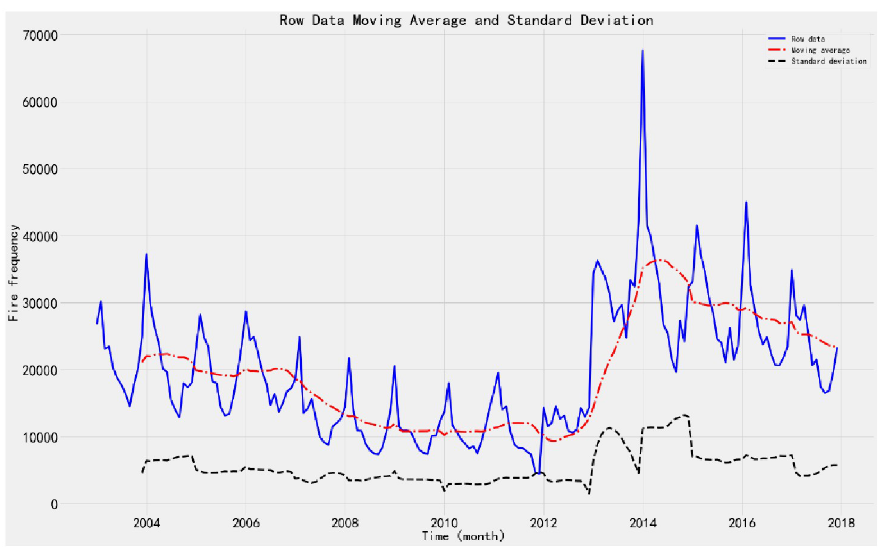
Fig 2. ADF test after 1-order 12 step difference. The first stage is from 2003 to 2011, showing a slow downward trend, the second stage is from 2012 to 2014, showing a rapid growth trend, and the third stage is from 2015 to 2017, showing a steady downward